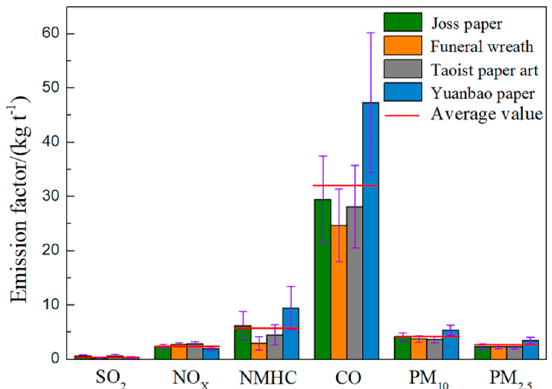
Figure 6. Emission factors of hazardous air pollutants from the incineration of sacrificial offerings.